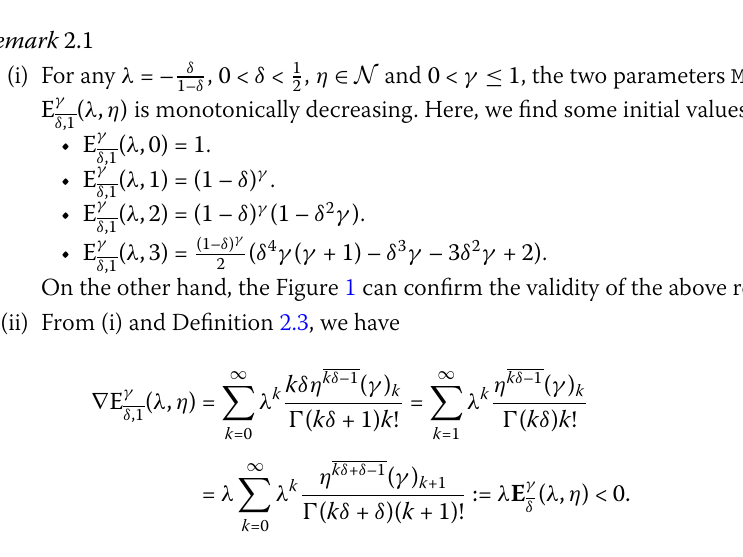
( λ , η ) for different values of δ ,1